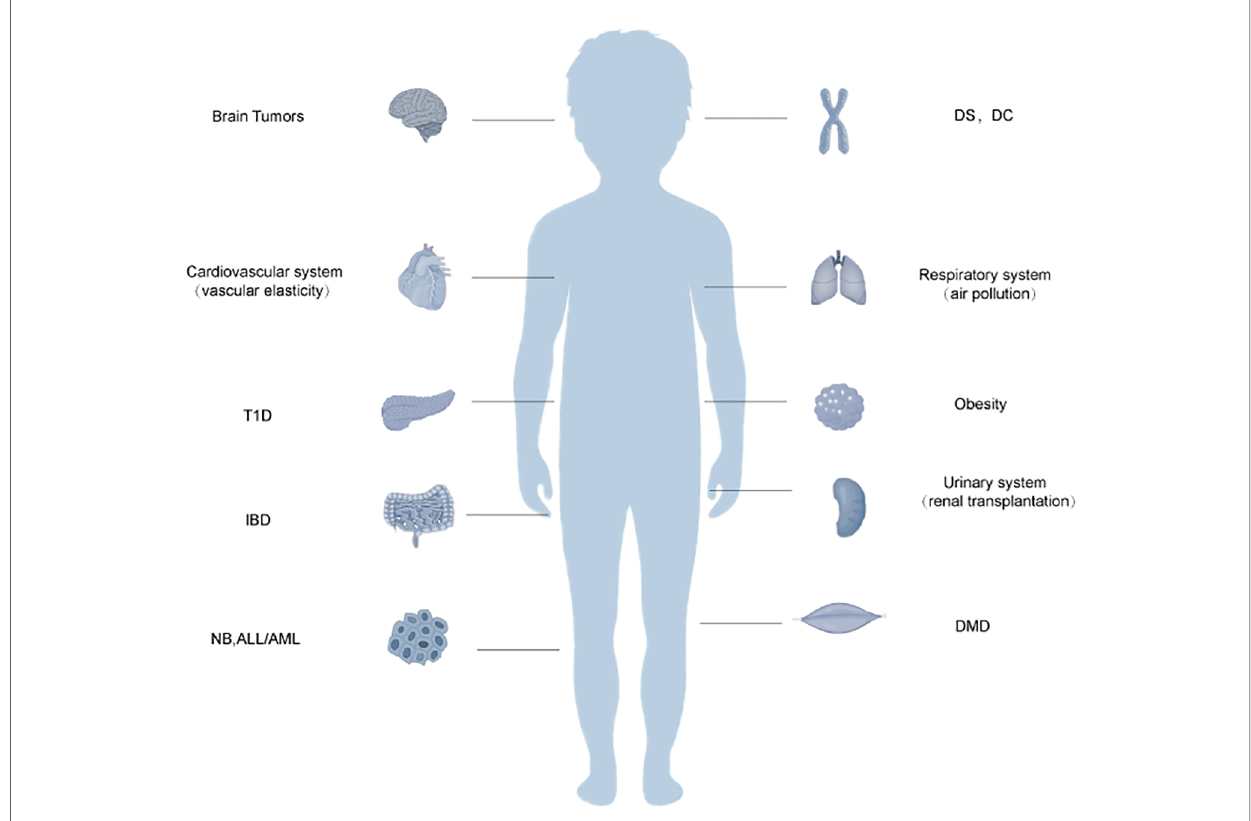
FIGURE 2 Schematic diagram of the relationship between telomere dysfunction and certain systemic disorders in older children. Acute lymphoblastic leukemia, ALL, acute myeloid leukemia; AML, dyskeratosis congenita; DC, Duchenne muscular dystrophy; DMD, Down syndrome; DS, in fl ammatory bowel disease; IBD, neuroblastoma; NB, type 1 diabetes, T1D. Telomere dysfunction may also be related to the body systems in children. It may be related to vascular elasticity in the cardiovascular system. In the respiratory system, it can enhance the sensitivity of the respiratory tract to air pollution. In the urinary system, it may be related to the success rate of renal